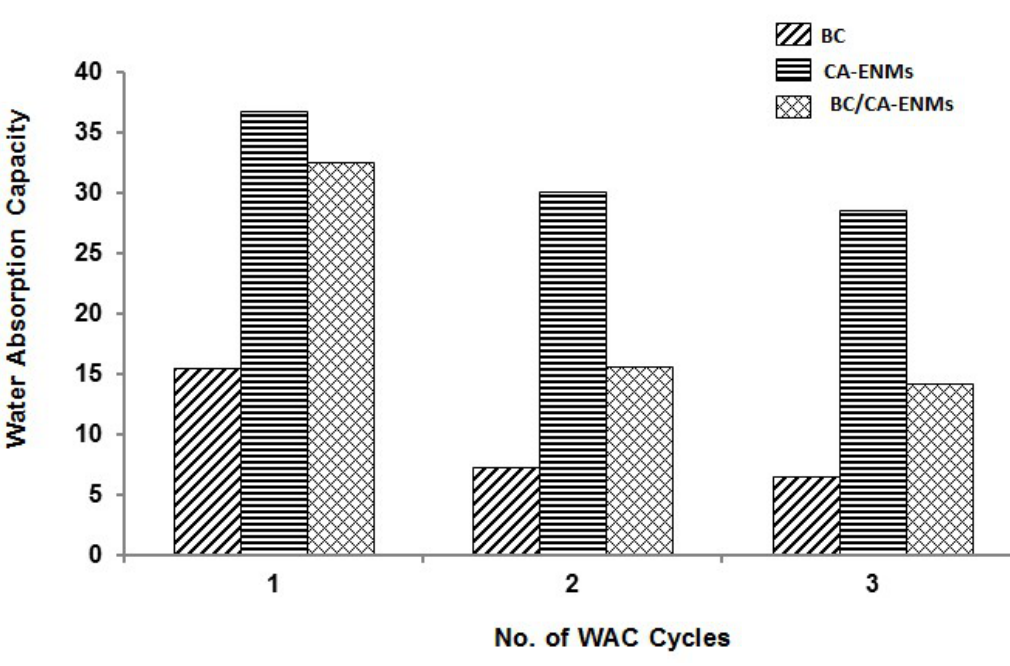
Figure 9. Percentage of the water absorbed in the BC films, CA-ENMs, and BC/CA-ENM hybrid mats after three wetting-drying cycles.